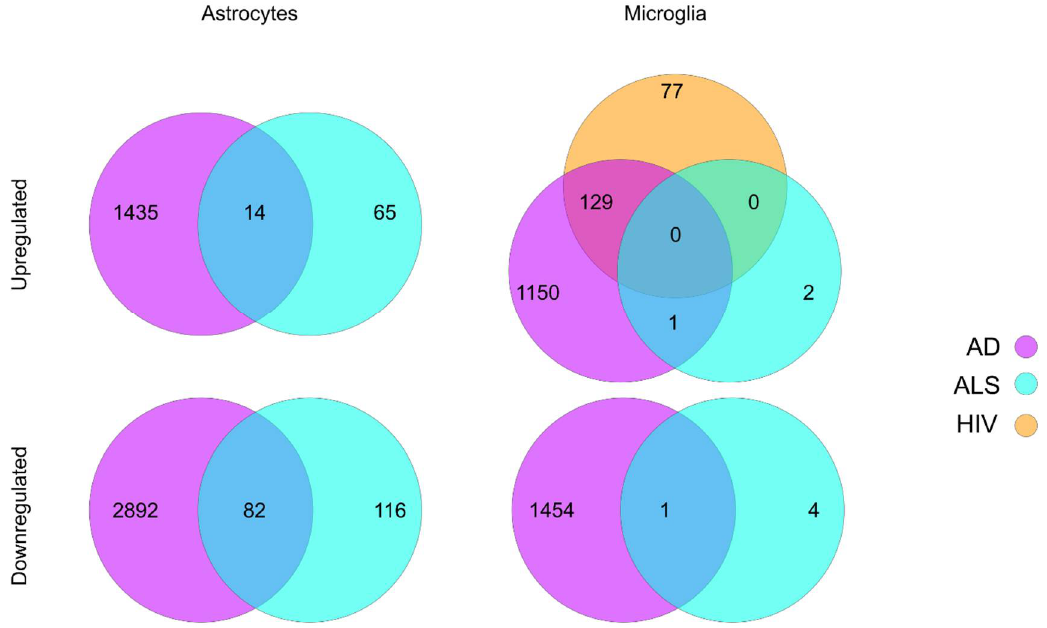
Figure 1. Summary of differential gene expression in astrocytes and microglia reported in sc/snRNA-seq studies of ALS, AD, and HIV. Lists of differentially expressed genes were acquired from the respective papers and filtered based on the reported adjusted p value [6,33,34,78]. Upregulated genes were identified based on a log fold change or z-score greater than zero, while downregulated genes were identified based on a log fold change of z-score less than zero.